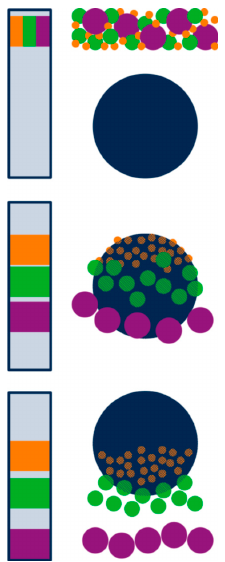
Figure 8. Separation principle of size exclusion chromatography showing the packed column ( left ) and one selected bead ( right ) during injection ( top ), separation ( middle ), and elution ( bottom ) of a three-component mixture. Proteins are separated according to decreasing size due to a reduction in available pore volume for larger molecules. Adapted from [128], reproduced with permission from John Wiley and Sons, 2011.